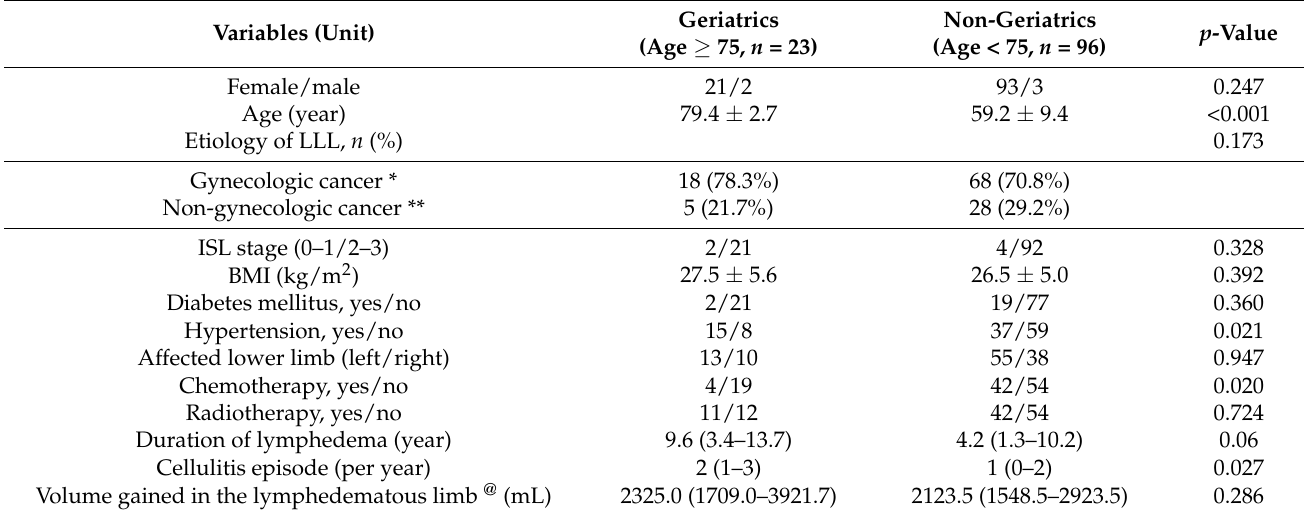
Table 1. Demographic and clinical characteristics of the